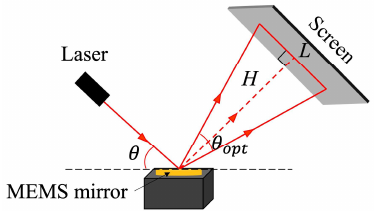
Figure 5. The schematic drawing of the device characterization experimental setup.